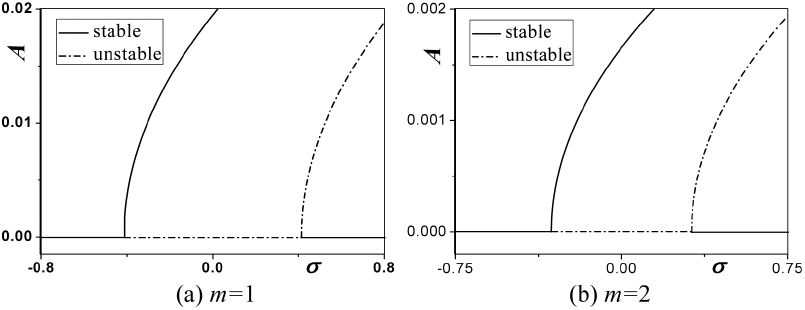
Fig. 2. Amplitudes and stability of steady-state responses: Eq.